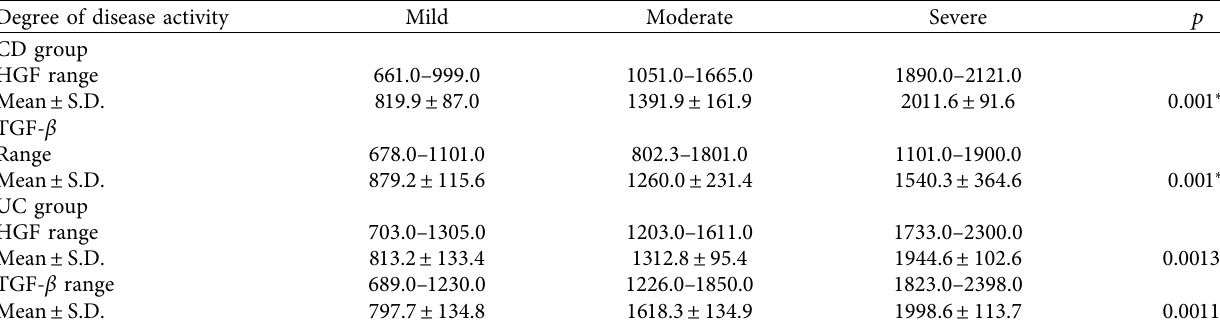
Table 2: Relation between plasma levels of HGF and TGF- β and degree of disease activity in the CD group and the UC group. Degree of disease